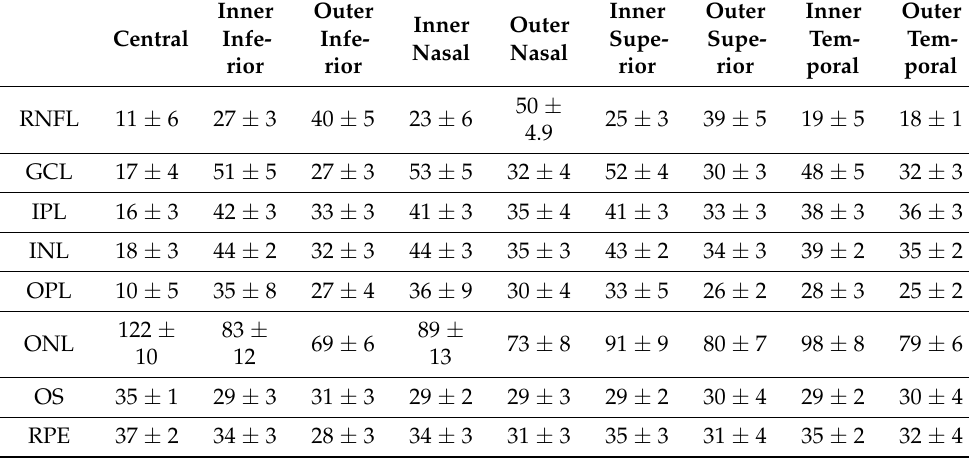
Table 1. Thickness values of the eight retinal layers in the ETDRS macular sectors. Inner Outer Inner Outer Inner Outer Central Infe- Infe- Nasal Nasal rior rior